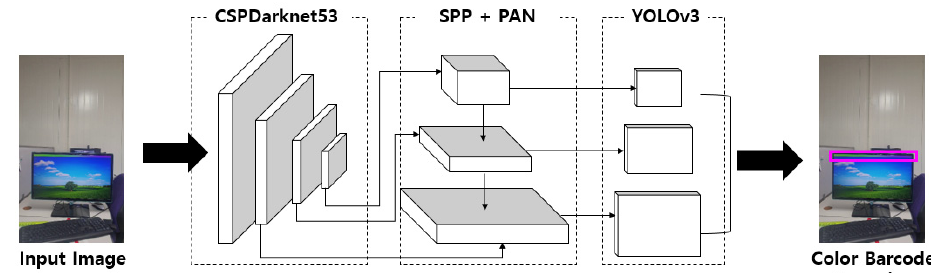
Figure 4. Architecture of YOLO-based color barcode detection.